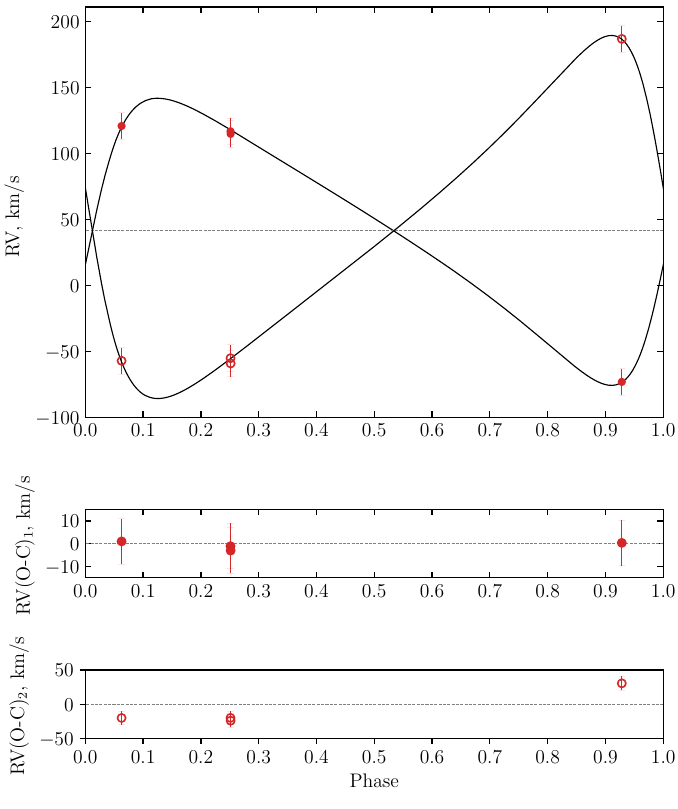
Figure 7. Possible orbital solution for